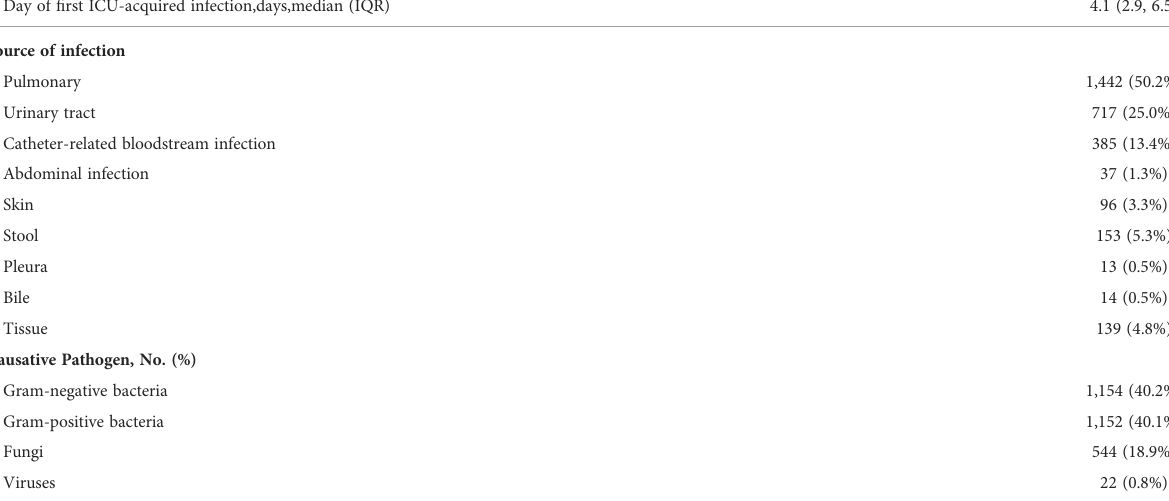
TABLE 2 Characteristics of ICU-Acquired Infections After Admission for